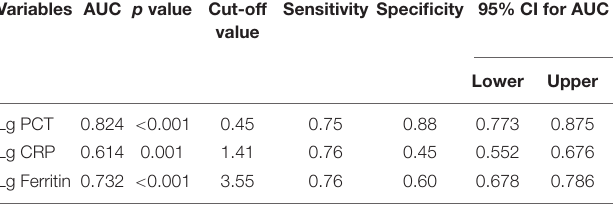
TABLE 3 | Predictive values of parameters for the severity of